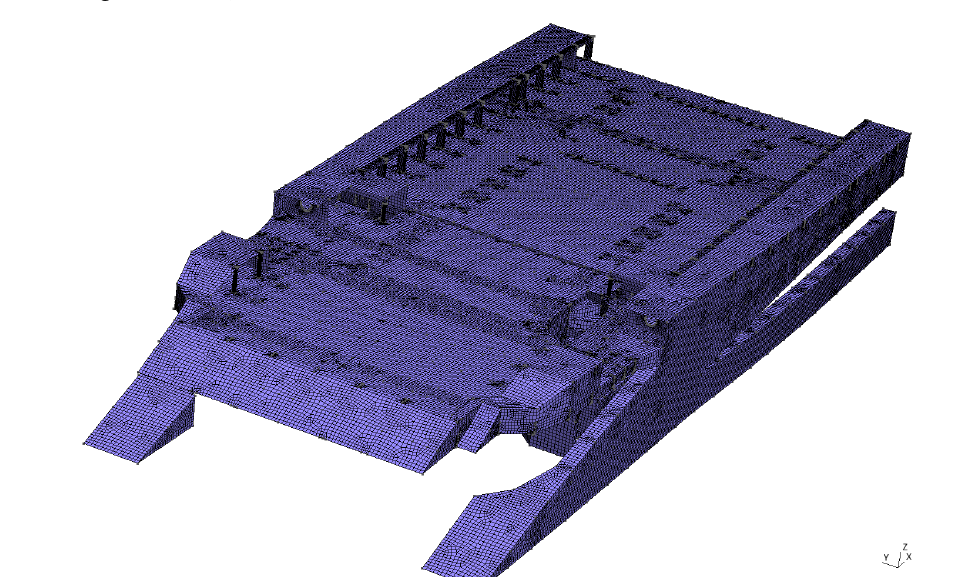
Figure A1. A pyREMAKEmsh mesh for G 3 .